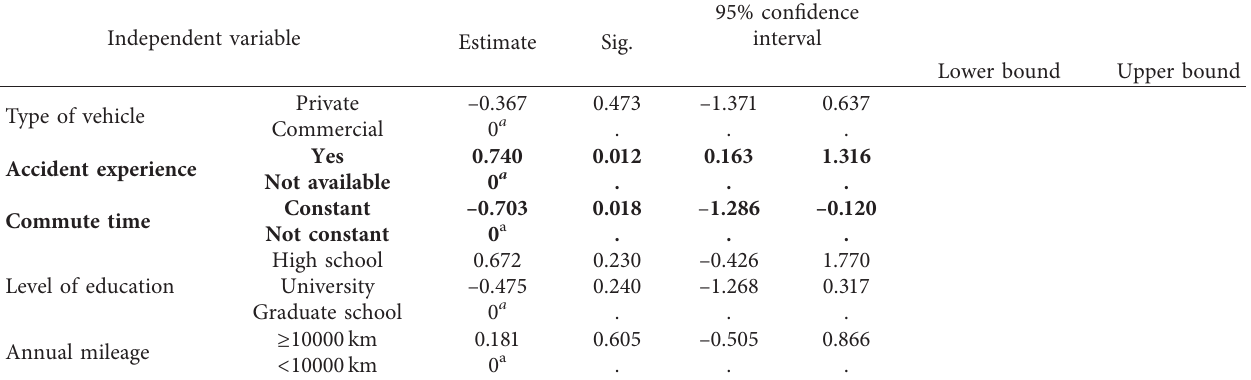
Table 6: Level of trust in road freezing information: ordinal logistic regression model estimation